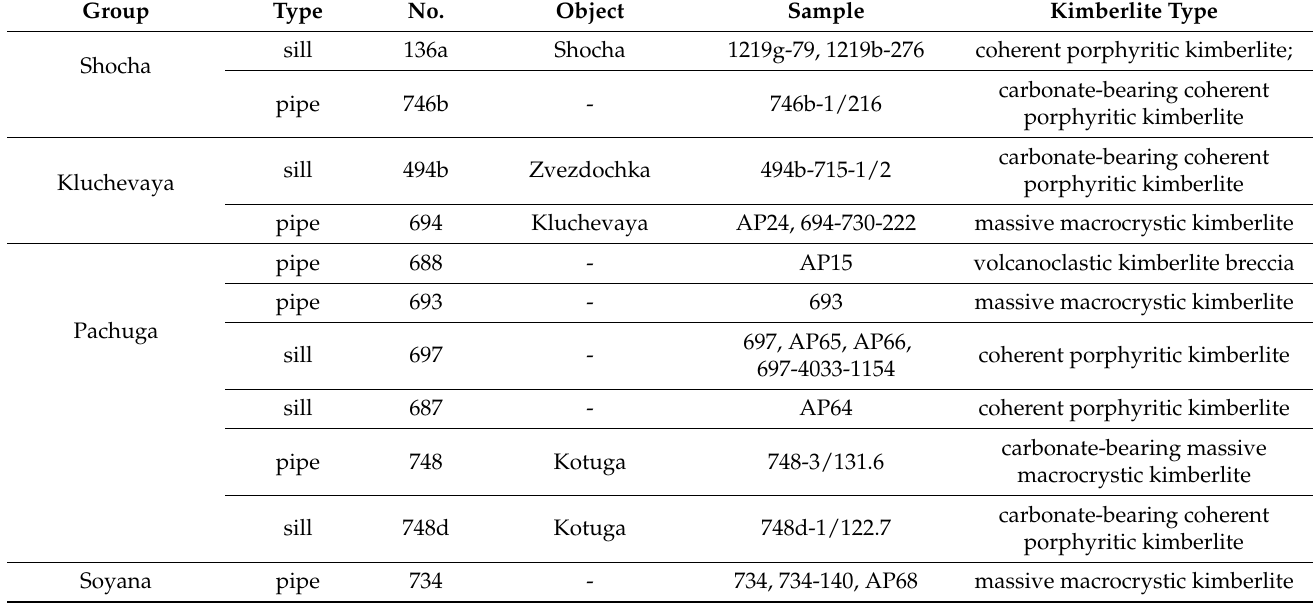
Table 1. The studied sills and pipes from the Kepino